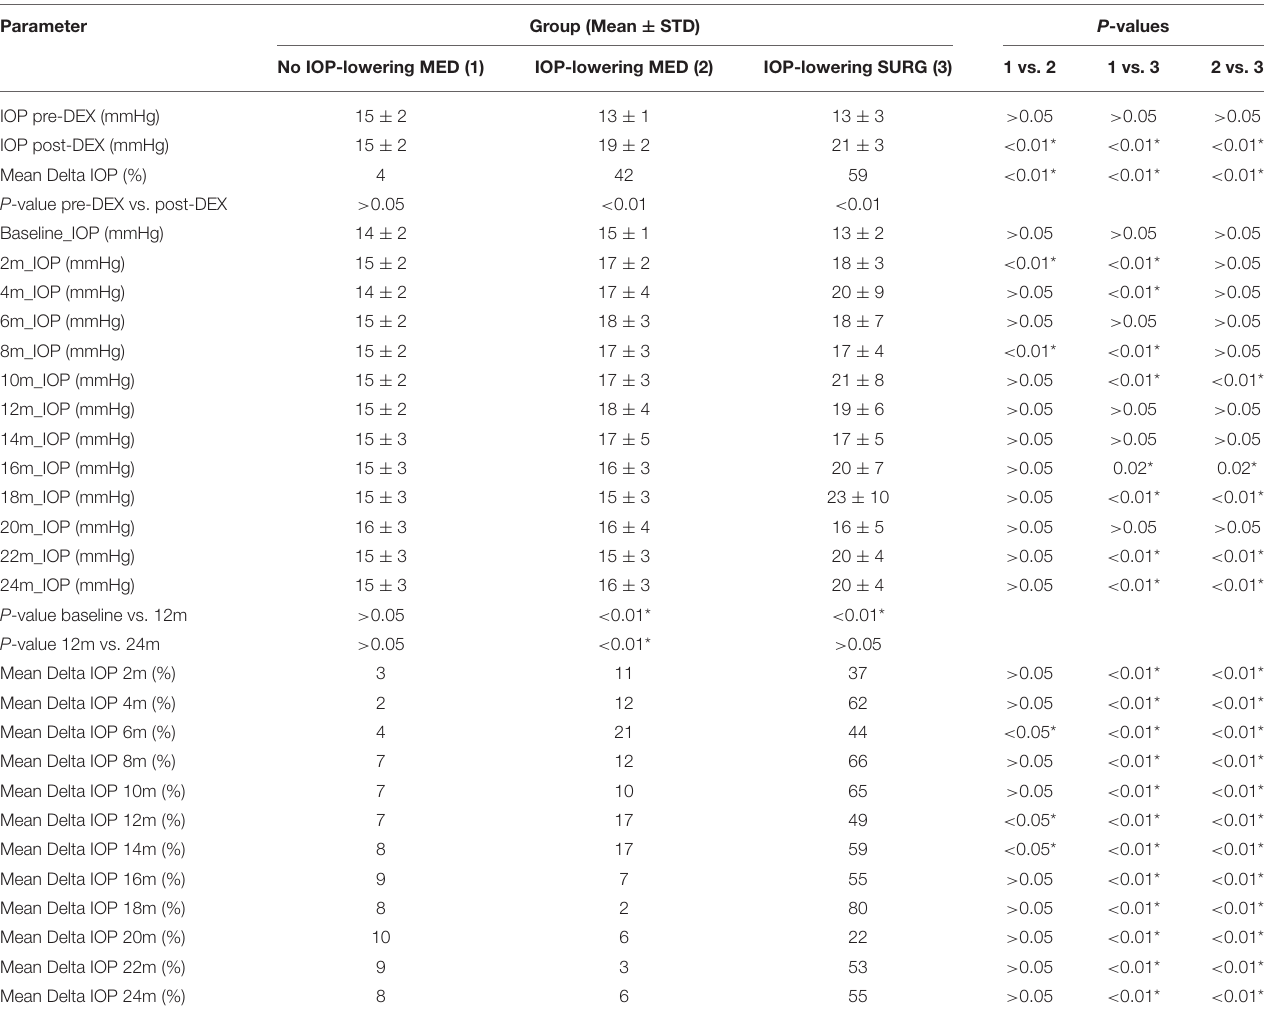
TABLE 3 | Intraocular pressure (IOP) values in the subgroup analysis. Parameter